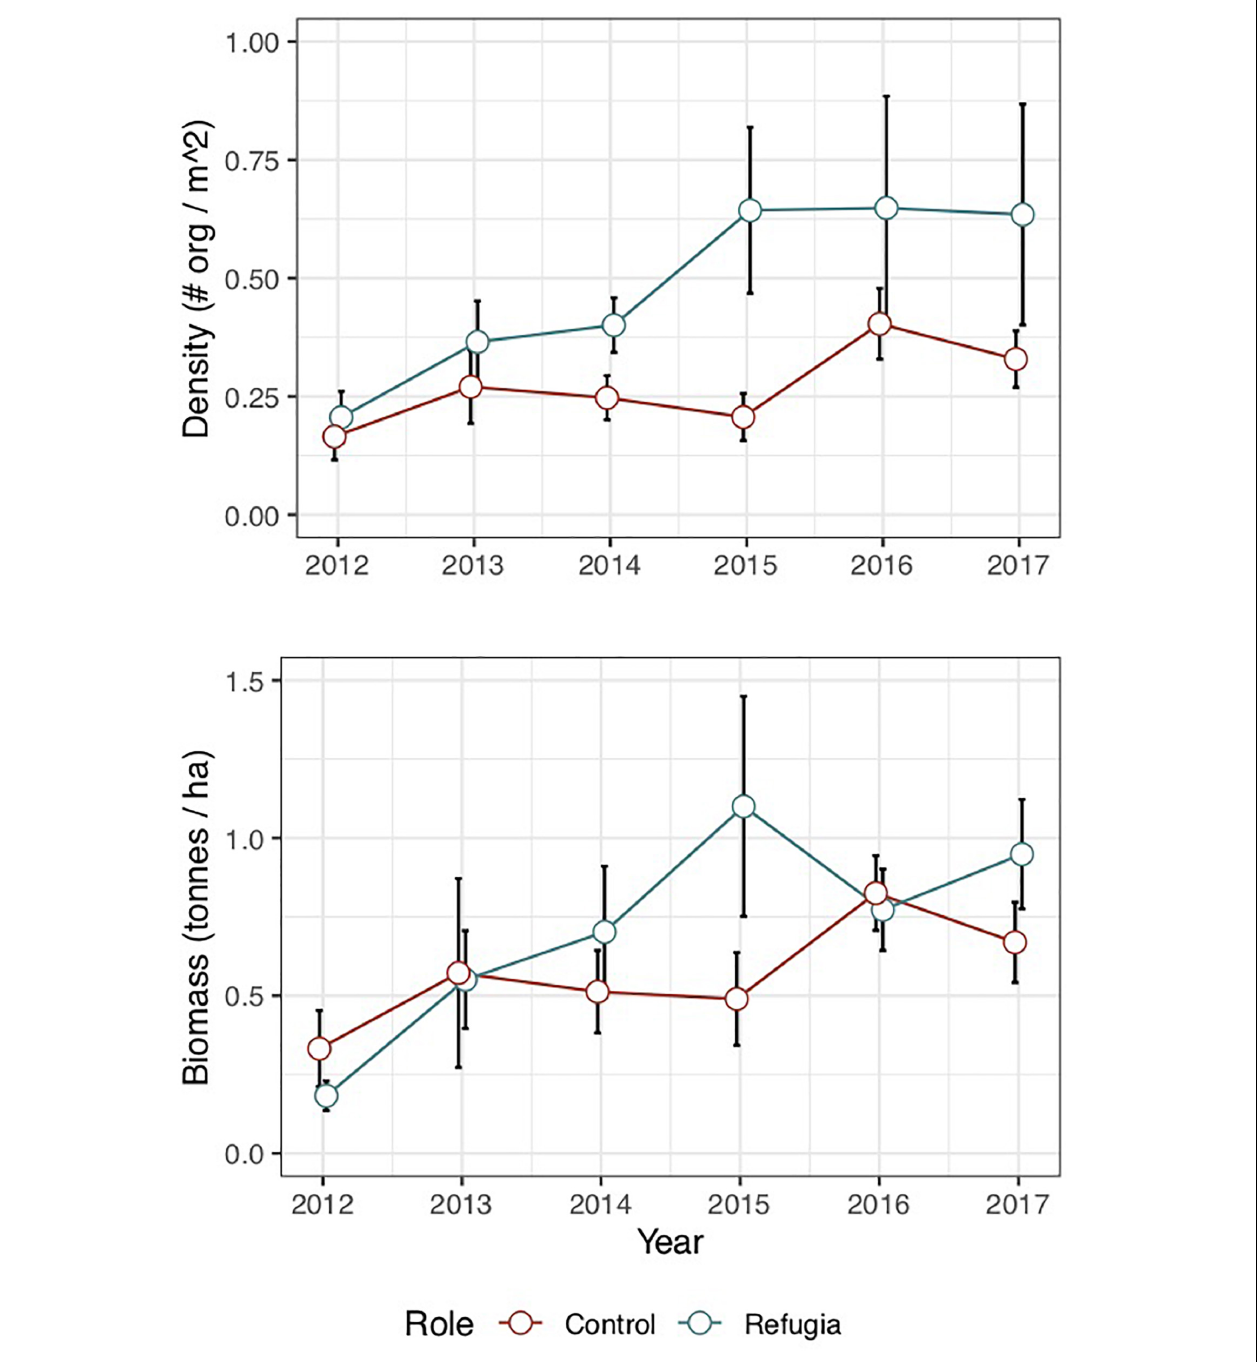
FIGURE 3 | Comparison of ecological parameters (biomass and density) between fishing refugia (blue) and control sites (red) from 2012 to 2017, from transect monitoring data. Trends show increase in both biomass and density over time, with significantly greater increases in fishing refugia.